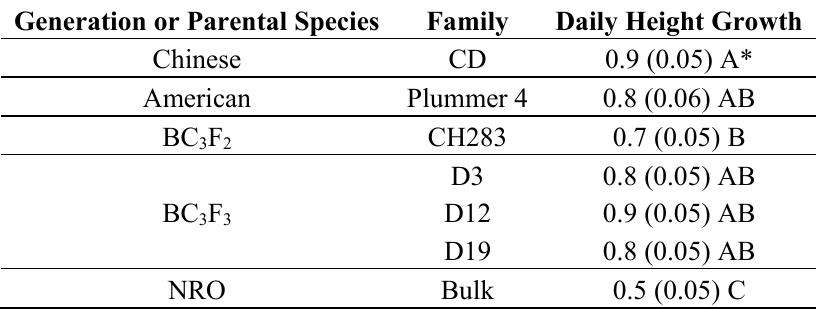
Table 8. Least squares means differences in daily height growth (cm) for each breeding generation/parental species and genetic family. Standard errors are in